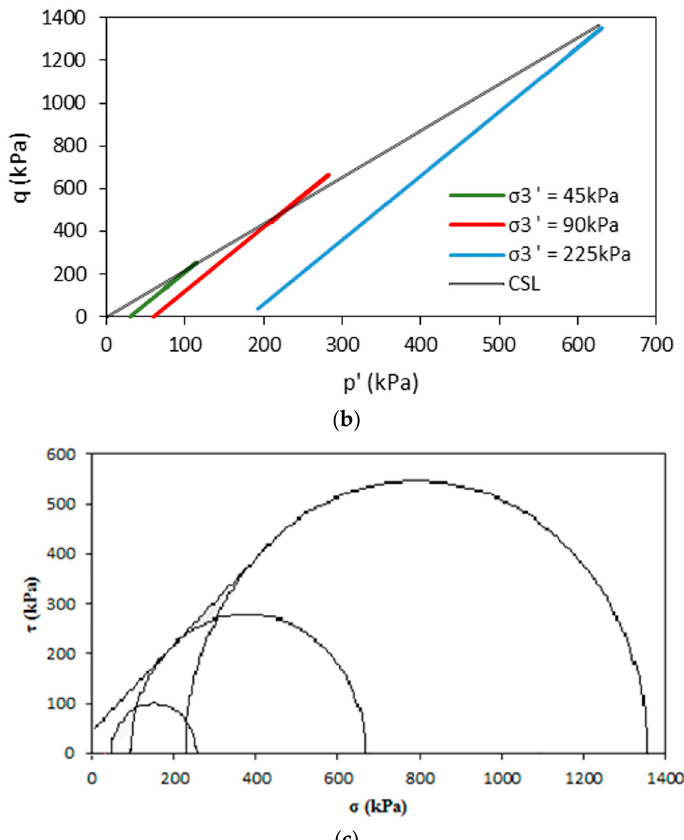
Figure 4. Results of static triaxial tests on RCA: ( a ) stress-strain curves; ( b ) effective stress paths and ( c ) Mohr–Coulomb effective failure envelope.